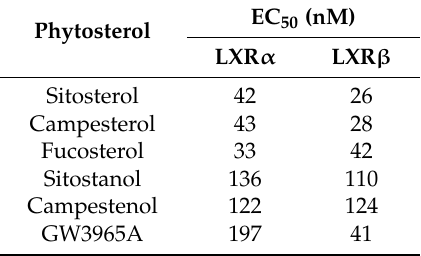
Table 1. EC 50 values of selected phytosterols evaluated in a coactivator peptide recruitment assay.